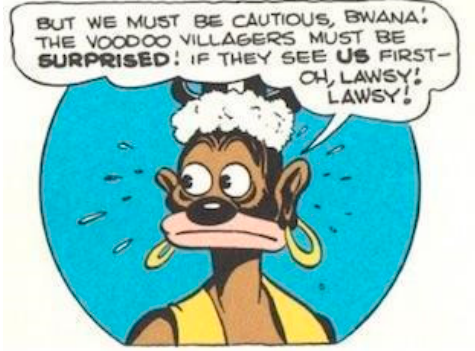
Figure 3. Blackface in Donald Duck Voodoo Hoodoo (1949).